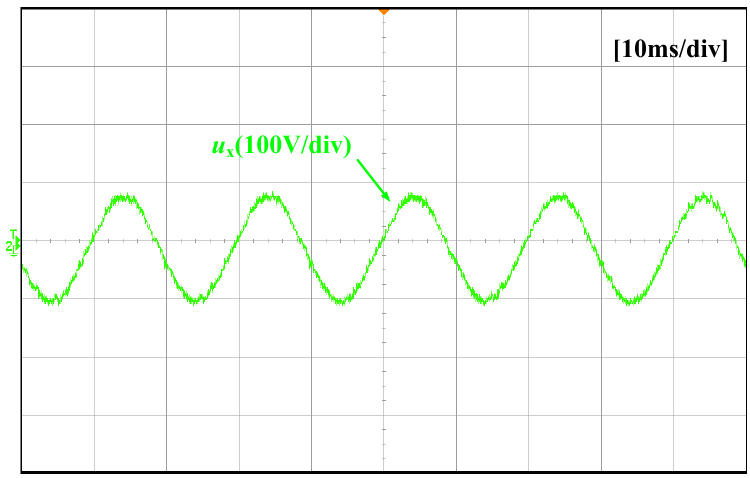
Figure 34. Experimental results of the SCSM capacitor voltages.